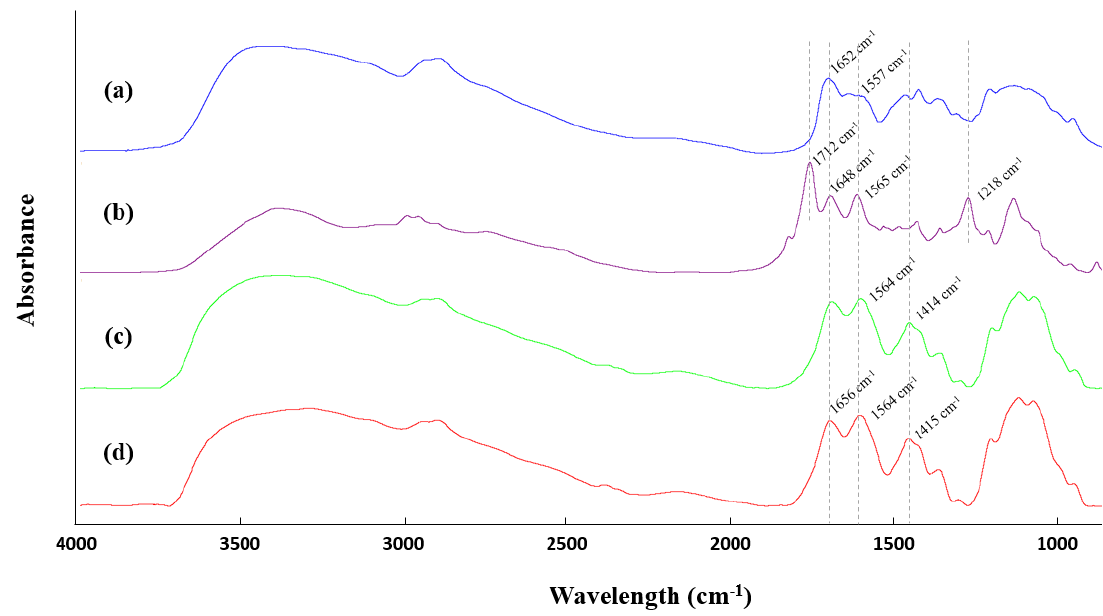
Figure 1. FT-IR spectra of the crosslinked CS films: ( a ) neat CS, ( b ) CSCA 1, ( c ) CSGTA 1, and ( d ) CSGP 1. In the case of CSGTA, infrared (IR) peaks were observed at 1564 and 1414 cm − 1 , corresponding to C=N (stretch) of the imine bond and C–H (bending) between the aldehyde group of GTA and primary amine in CS due to a nucleophilic addition reaction [14,22]. Likewise, the CSGP showed peaks at 1656, 1564, and 1415 cm − 1 , corresponding to C=O (stretch)/N–H (bending) of the amide bond and C–H (bending) of the methyl ester group in GP, respectively [19,23]. However, using only FT-IR spectra to confirm the crosslinking reaction of CSCA, CSGTA, and CSGP films was difficult and insufficient because their IR peaks overlapped with those of the primary amine and newly formed amide bonding of neat and crosslinked CS. Thus, a solubility test was performed to determine whether the CS films were crosslinked or